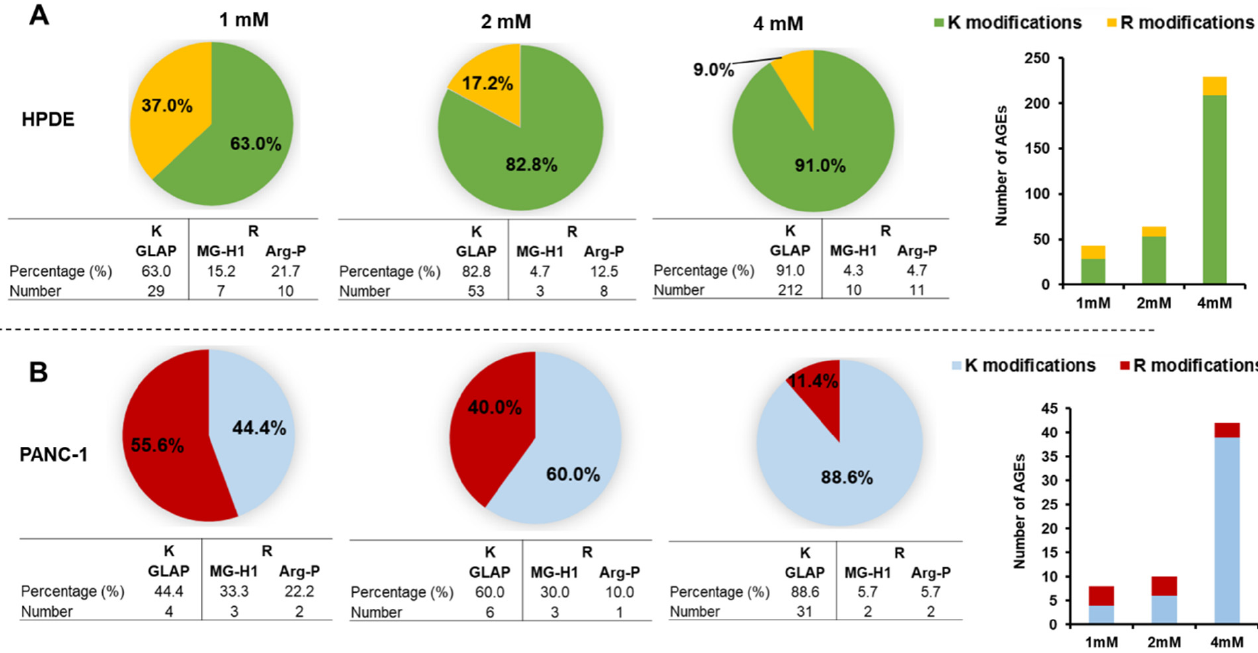
Figure 6. Mass spectrometric identification of 13 C 3 -glyceraldehyde derived K/R AGE modifications in cellular proteins of HPDE ( A ) and PANC-1 ( B ) cells. GLAP: Glyceraldehyde derived pyridinium type advanced glycation end product, Arg-P: Argpyrimidine, MG-H1: N δ -(5-hydro-5-methyl-4-imidazolon-2yl) ornithine.